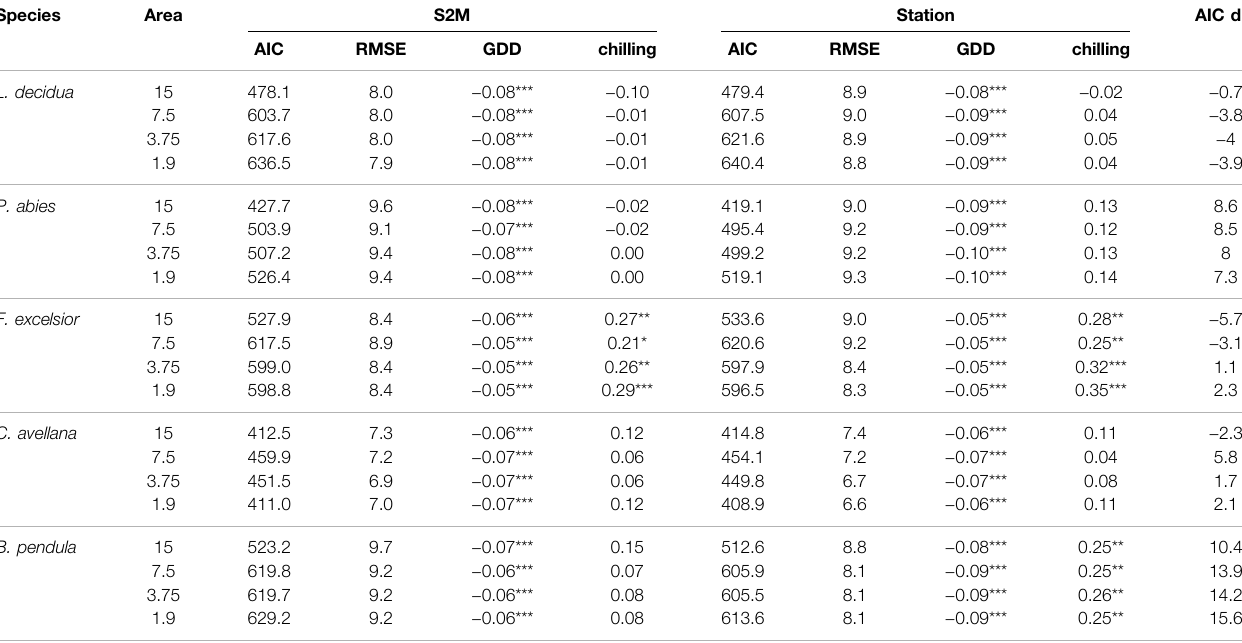
TABLE2| EstimatesandAICfromlinearmixedmodelstestingtheeffectsofGDDandnumberofchillingdayson fi vetreespeciesbudburstdates,usingS2Morstationdata, and their AIC difference (S2M - station model). Models were tested with phenological data observed at a distance inferior to 15, 7.5, 3.75, and 1.9 km from the closest